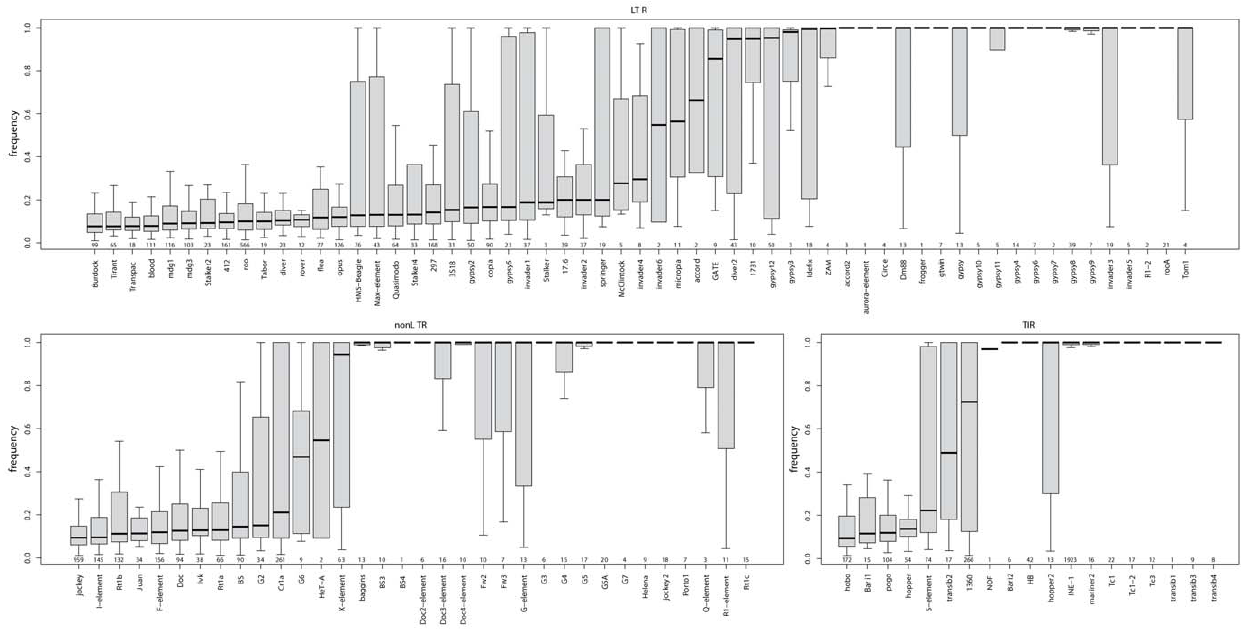
Figure 4. Boxplots of population frequencies in our natural population of D.melanogaster for all major TE families found in the Portuguese D.melanogaster population. The number of TE insertions whose frequencies are represented is indicated below the boxplot; only non-overlapping insertions were used to calculate population frequencies.